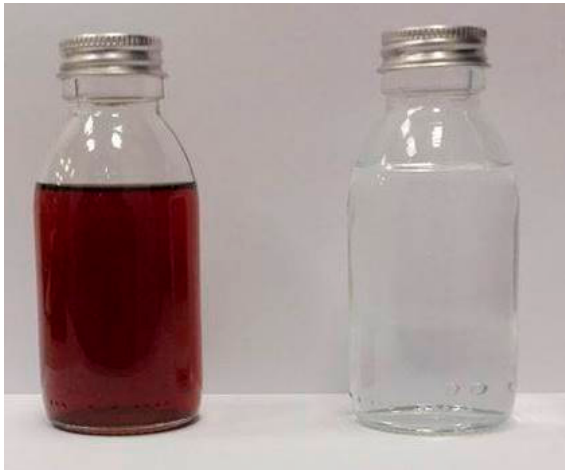
Figure 5. Mid-distillate fraction of waste plastics pyrolysis oil before (left) and after (right) catalytic hydrotreatment upgrading at CERTH.